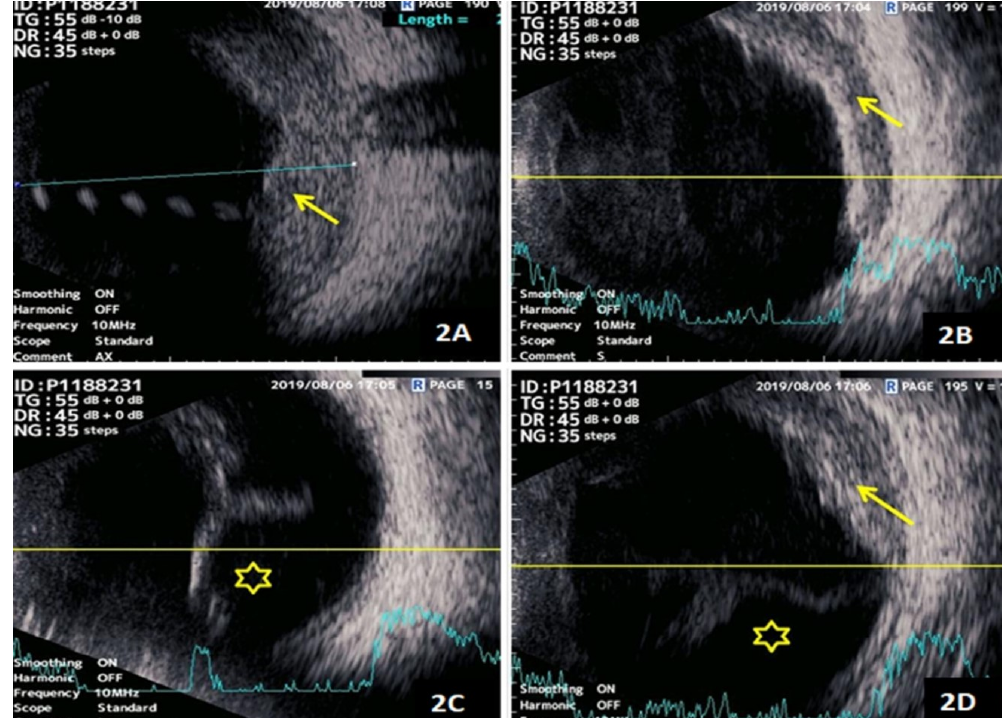
Figure 2: A) Right-eye ultrasound B-scan in the axial scan showed an elevated mass lesion in the choroid with moderate to high internal echogenicity (yellow arrow). B–D) The transverse and dynamic ultrasound B-scans also showed presence of exudative retinal detachment in the inferior and nasal scans (yellow asterisk in 2C and 2D) with elevated moderate to high echogenic choroidal lesions in the superior and nasal scans (yellow arrow in 2B and